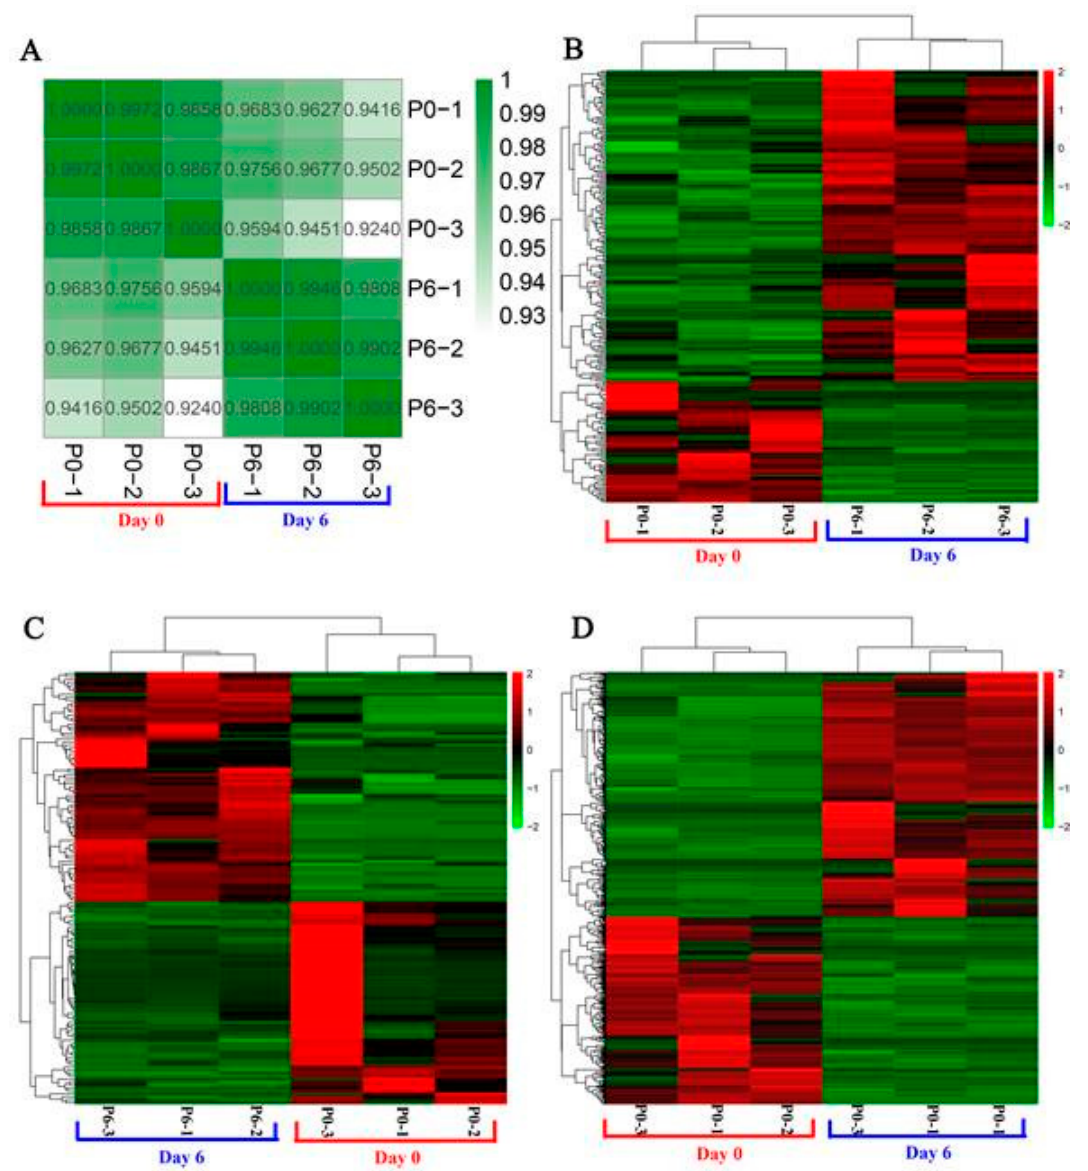
Figure 2. Heatmaps of sample correlation and differentially expressed genes. ( A ) Sample correlation heatmap. Dark green indicates a high correlation. ( B ) Heatmap for differentially expressed long noncoding RNAs (lncRNAs). ( C ) Heatmap for differentially expressed microRNAs (miRNAs). ( D ) Heatmap for differentially expressed mRNAs. Red indicates highly expressed genes, and green indicates lowly expressed genes.